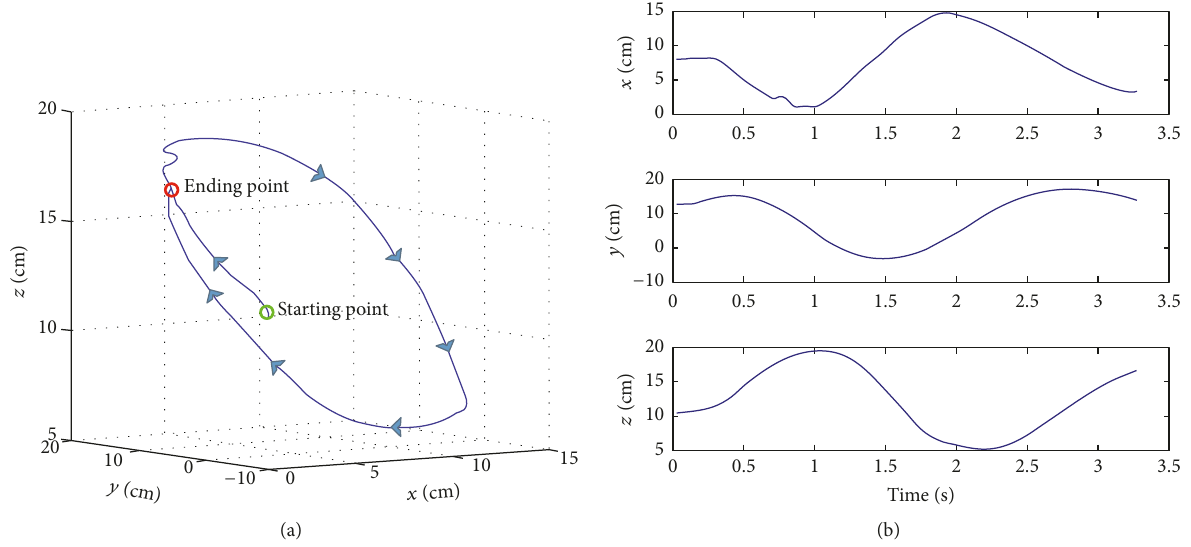
Figure 13: (a) Reconstructed 3D trajectory when hand moving in a circle; (b) represented in 𝑥 , 𝑦 , and 𝑧 directions.